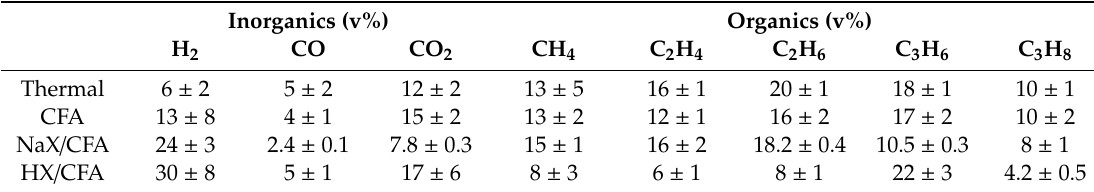
Table 4. Chemical composition of pyrolysis gases.